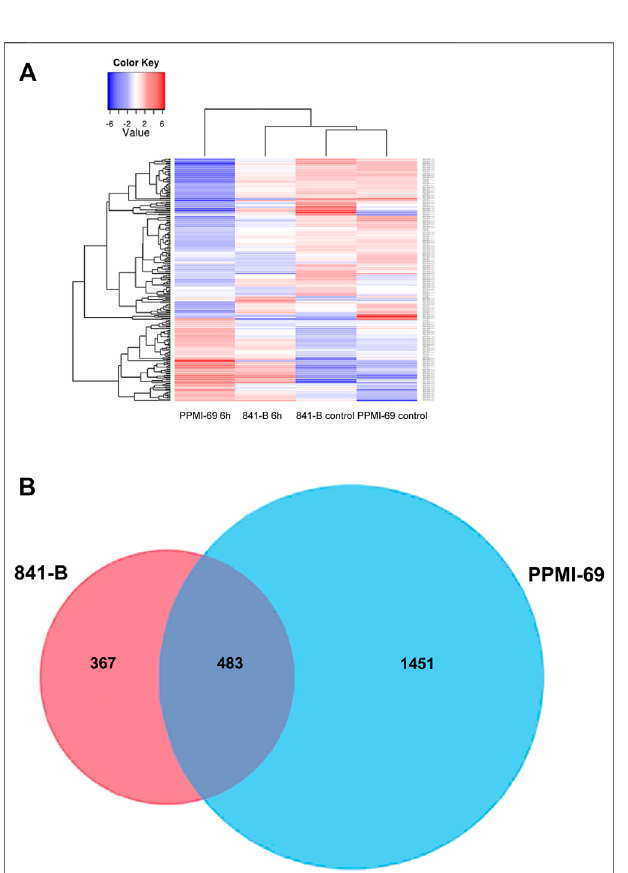
FIGURE 6 | Representation of heat stress responsive genes. (A) - Heatmaps of the signi fi cant differentially expressed genes with hierarchical clustering. (B) - Venn diagram of the differential expressed genes under heat stress conditions in 841-B and PPMI-69 genotypes.